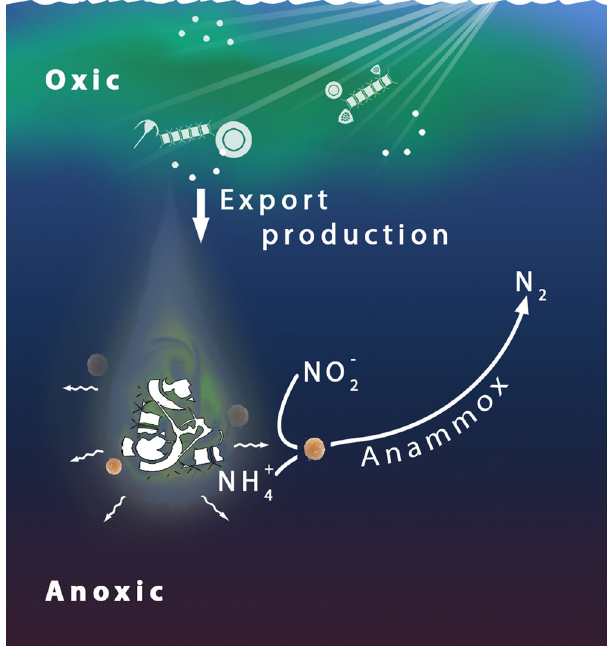
Fig. 7 Schematic illustration showing interactions between anammox bacteria and particles within the Peruvian oxygen minimum zone (OMZ).